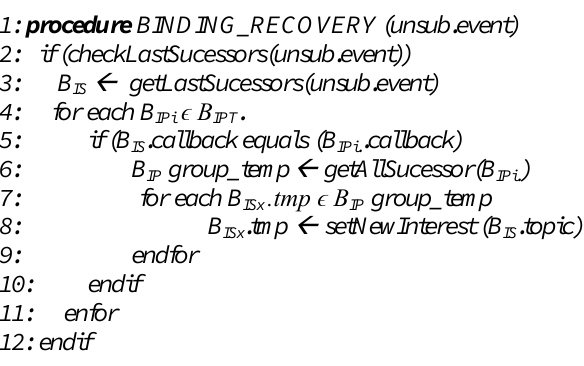
Figure 5. Binding recovery